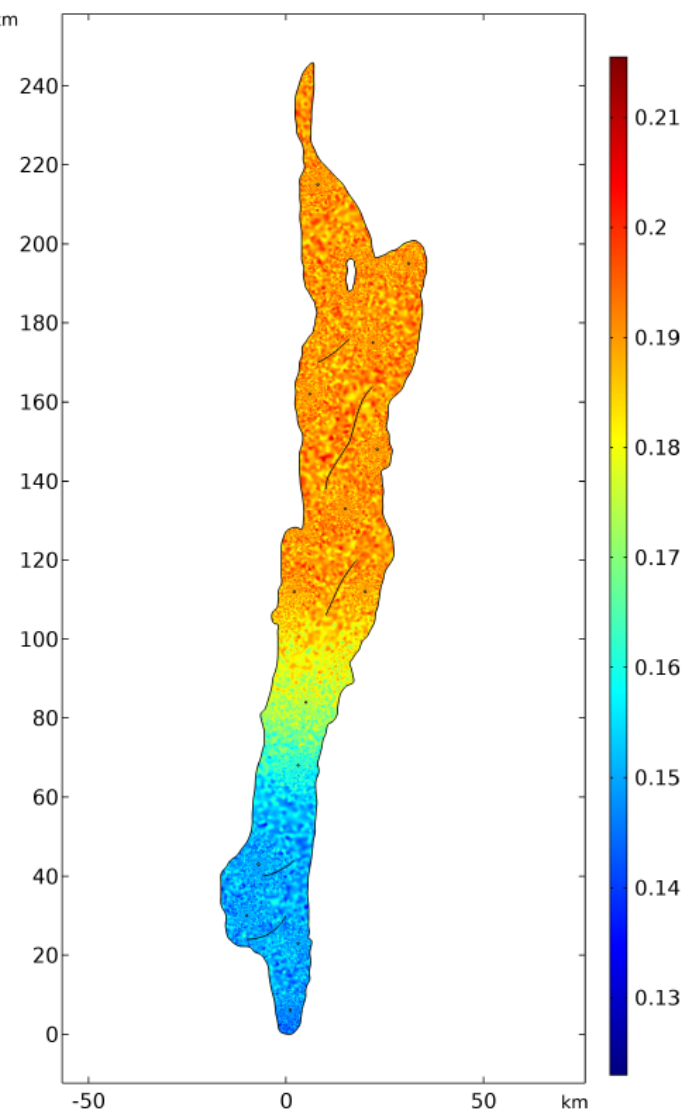
Figure 9. Porosity field of the Ghawar field used during the